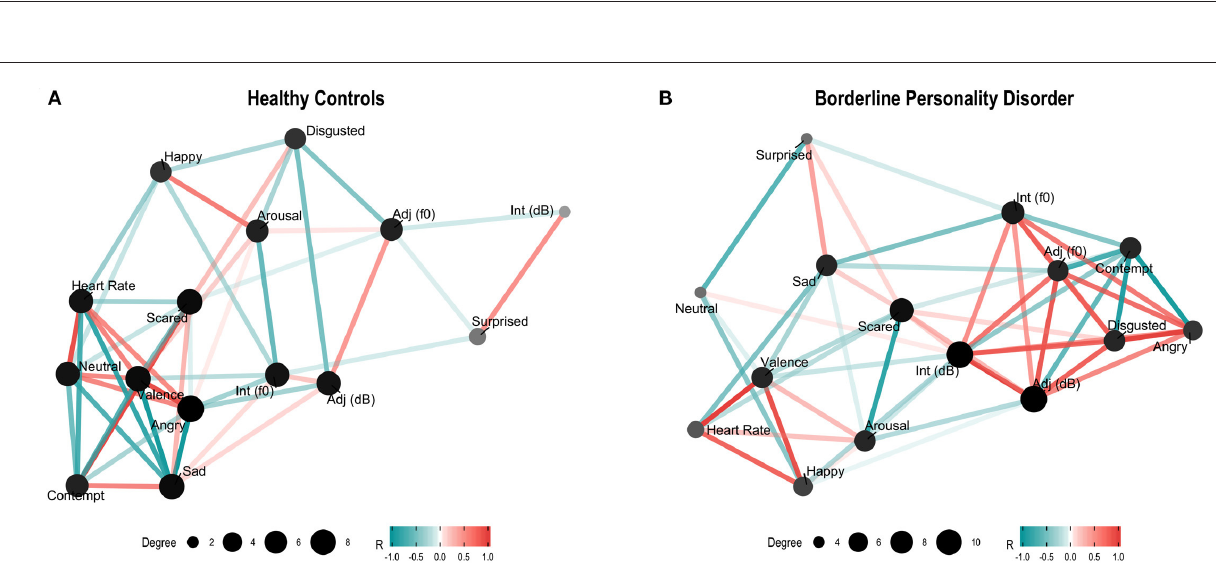
FIGURE 1 | Correlation matrices established among emotional variables (Neutral, Happy, Sad, Angry, Surprised, Disgusted, Valence, Arousal) and acoustic parameters ( f0, dB ) of controls (A) and patients (B) . The correlation index on each cell is displayed in a gradient of colors where red represents a positive correlation (0 > r > 1); blue, a negative one ( − 1 < r < 0); and white the absence of revelent correlation.